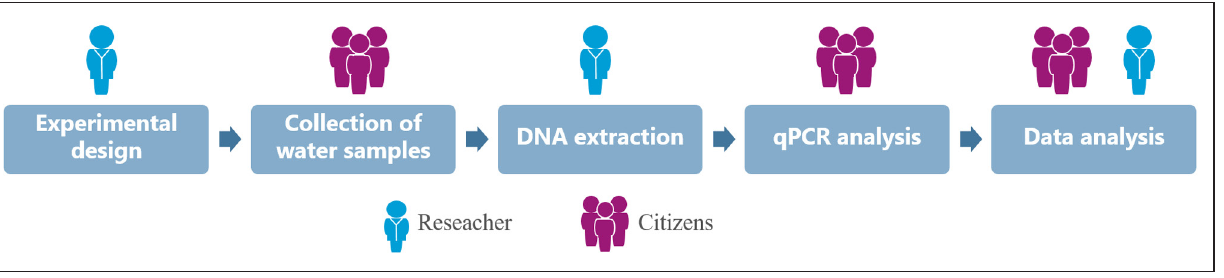
Figure 2 Schematic overview of the project “DNA & Liv” (abbreviated DL) offered by the Natural History Museum of Denmark as a teaching programme for high school students. The figure icons above the boxes illustrate which parts of the process were conducted by a researcher or by citizens,